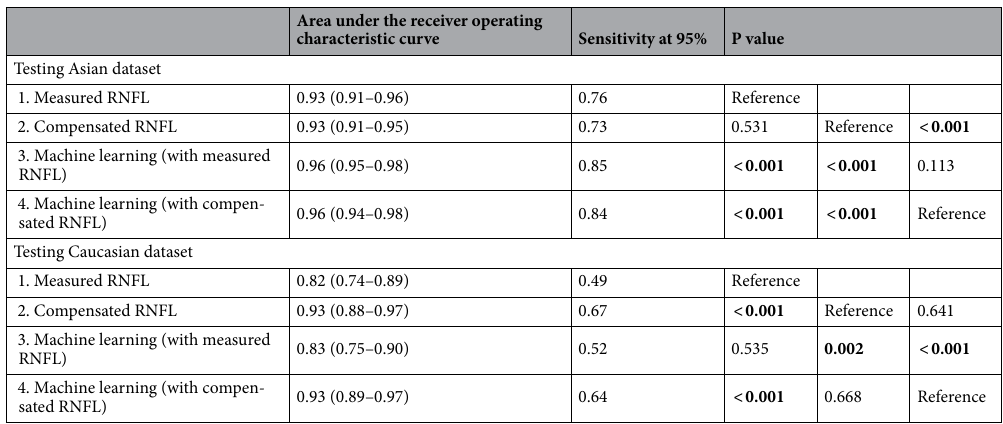
Table 2. Comparison of glaucoma detection between measured retinal nerve fibre layer (RNFL), compensated RNFL, and machine learning approaches. Data in parentheses are 95% confidence intervals. Results for sensitivity are expressed as percentages. P value was obtained with DeLong et al. (1988) for paired receiver operating characteristic curves and values in bold indicate statistical